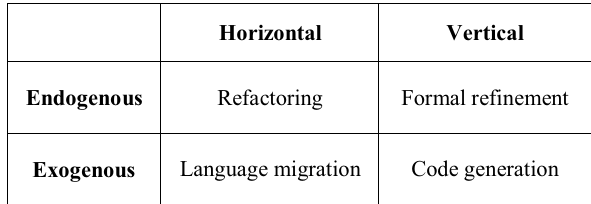
Table 1. Orthogonal dimensions of model transformations with examples